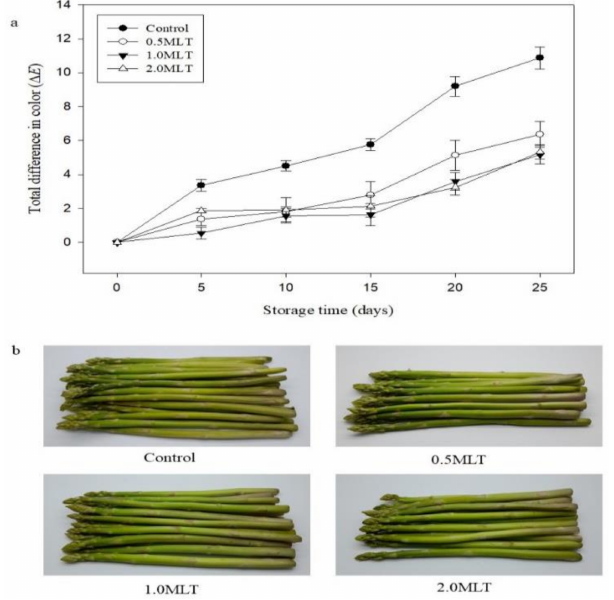
Figure 2. ( a ) Color change ( ∆ E ) in green asparagus during 25 days of storage at 4 ◦ C and 90% relative humidity. Treatment in melatonin solution: 0.5 MLT (50 µ M), 1.0 MLT (100 µ M), 2.0 MLT (200 µ M); control (distilled water). ( b ) Appearance of green asparagus after 25 days of storage.